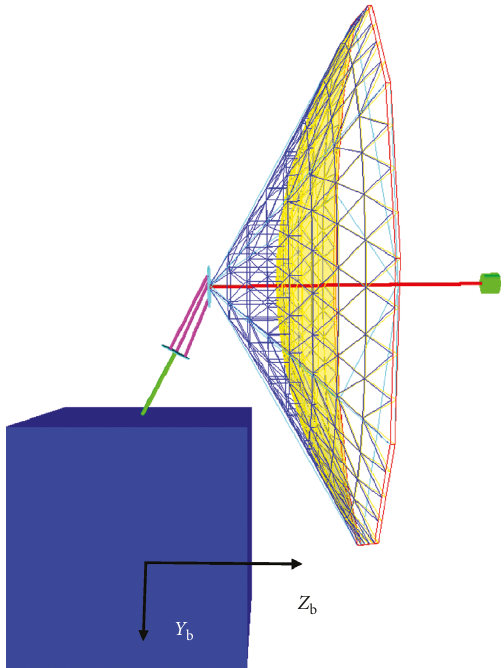
Figure 6: Status of the SSPCI for communication.